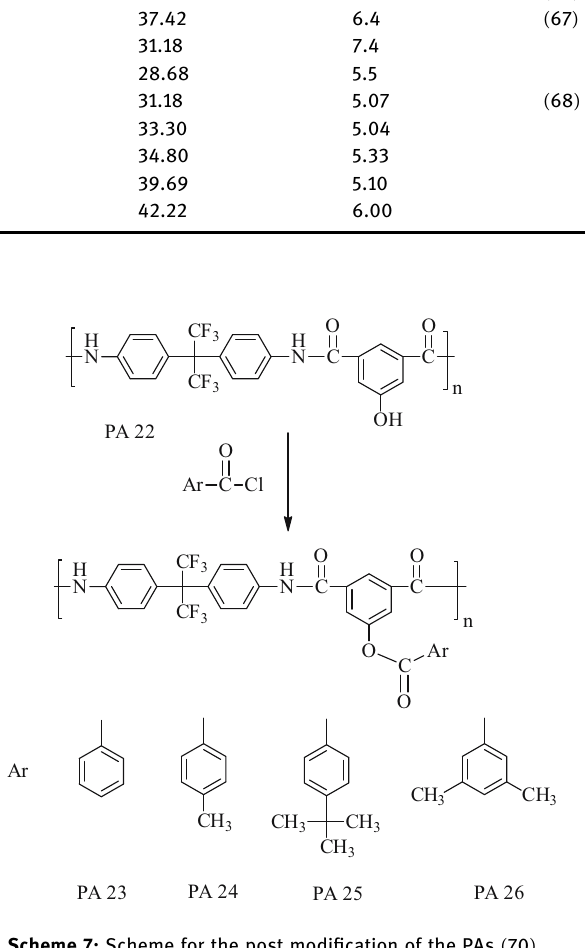
Scheme 7: Scheme for the post modi fi cation of the PAs ( 70 )